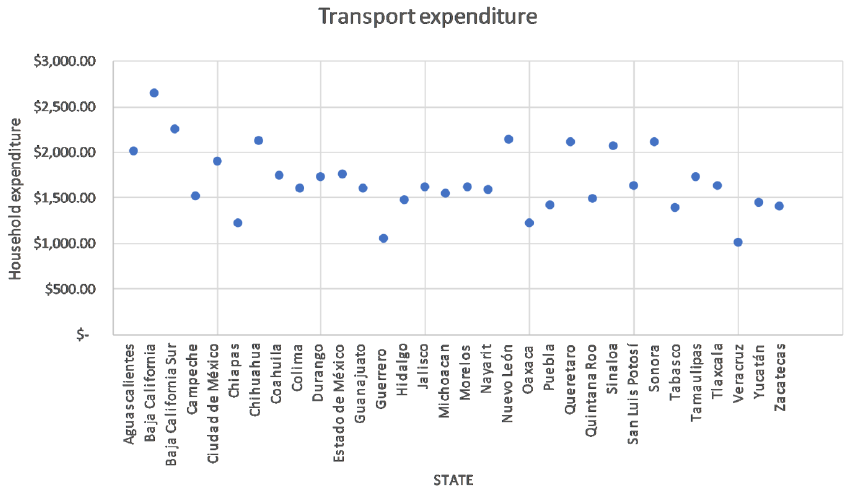
Figure 1. Average monthly transport expenditure per household in pesos, by State. Source ENCEVI, INEGI.